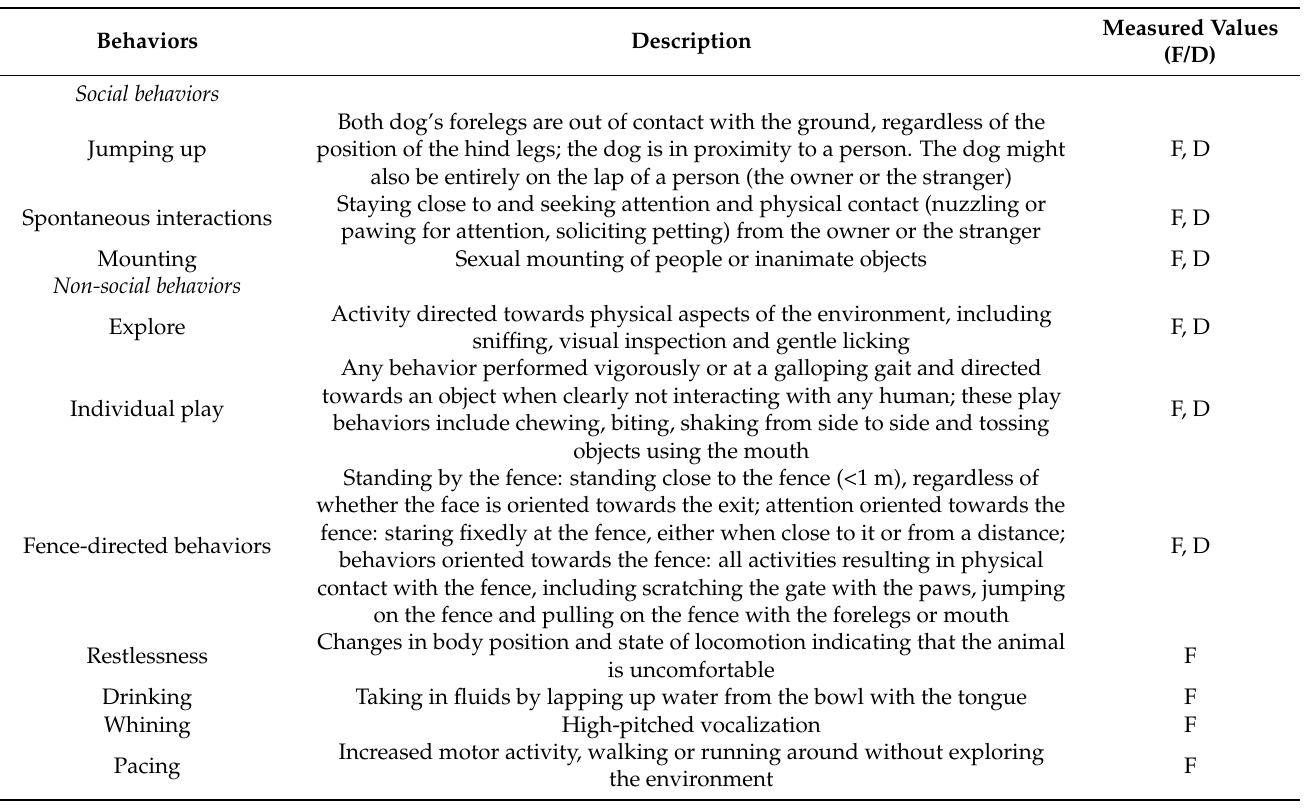
Table 1. List of behaviors and definitions used in the study. F = frequency (number of occurrences); D = duration